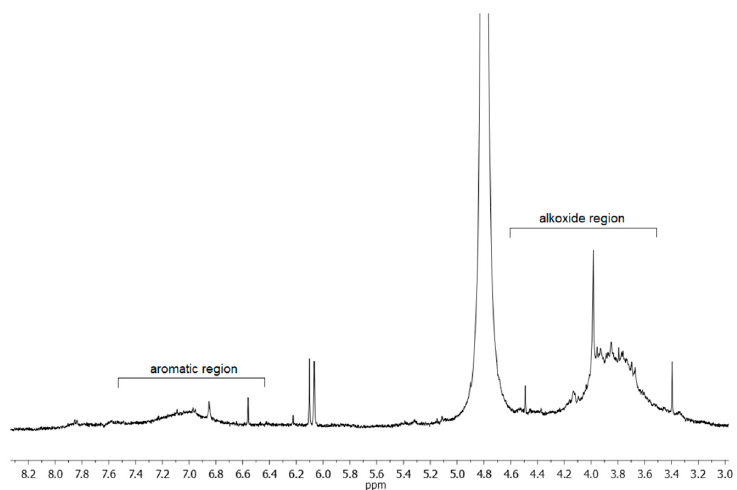
Figure 4. Portion of 1 H NMR spectrum of the egagropili lignin fraction in D 2 O (pH 12) at 298 K and 500 MHz. The intense peak at δ 4.8 ppm is due to non-deuterated water taken as reference. Therefore, to investigate whether hemicellulose-deriving carbohydrate fragments remained linked, either through phenyl glycoside, esters or benzyl ether covalent bonds, to the phenolic polymer during lignin extraction from the egagropili lignocellulosic material, monosaccharide composition analyses were carried out on the egagropili-derived fibers, LF, hollocellulose and cellulose. Figure 5 shows that eight different monosaccharides were detected in the untreated egagropili fiber sample: neutral sugars like fucose (Fuc), Arab, rhamnose (Rham), galactose (Gal), Glc and Xyl were identified, as well as an amino-sugar, glucosamine (GlcN), and an uronic acid such as GlcA (Figure 5A–D). Their representa- tivity ranged from 51.0% of Glc to the 0.6% of Fuc (panels A and D). The same monosac- charide composition was also found in the LF (panels B and D) but with different percent- ages, as Glc presence was greatly reduced. Conversely, only Glc was detected in the hol- locellulose and cellulose samples (panels C and D). Quantitative analyses indicated that carbohydrates were 28.3% of the dry weight of the untreated egagropili fibers and 72.5% of the LF dry weight. Fuc, Arab, Rham, Gal, Glc, Xyl, and GlcA were previously found also in the water extracts of Posidonia oceanica leaves, together with other sugars like man- nose and galacturonic acid, even though their relative abundance was quite different with percentages that varied up to 80% for Gal and up to 50% and 45% for Glc and Xyl, respec- tively [51]. Therefore, we conclude that LF obtained from egagropili contained one or more LCC(s) (27.5 lignin:72.5 carbohydrate).